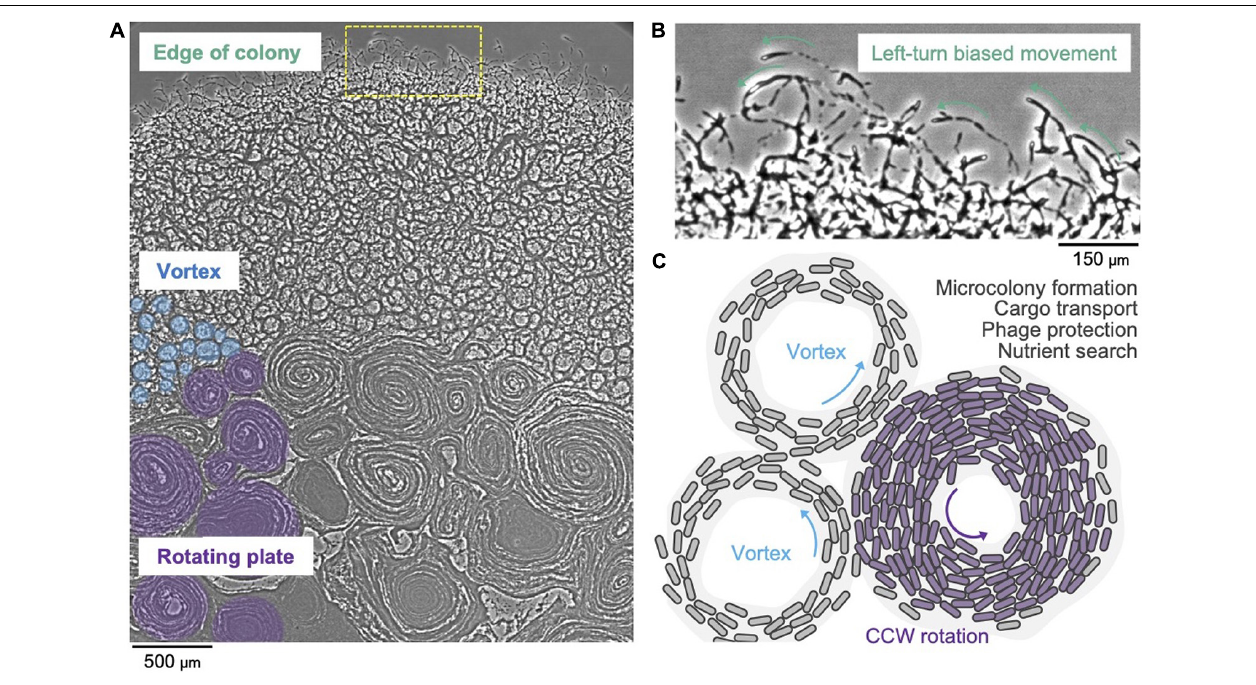
FIGURE 3 | Collective motion of gliding F. johnsoniae . (A) Colony spreading pattern in a starved environment. (B) Left-turn biased cell movement at the edge of the colony. (C) Schematic of the vortex pattern formation and its possible roles.